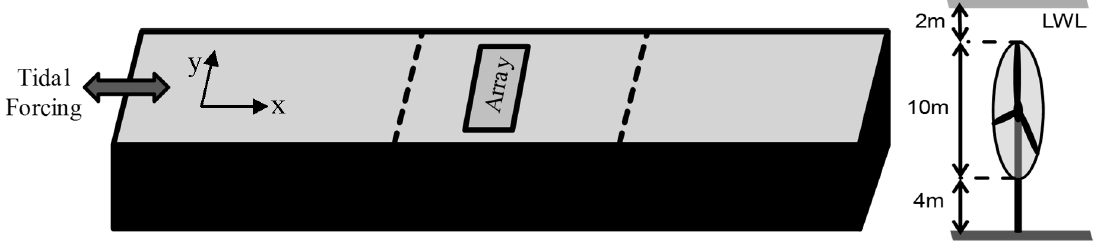
Figure 3. The modelled idealised channel showing the approximate location of the turbine array and the tidal turbine arrangement. Dashed lines indicate extents of the nested domain.